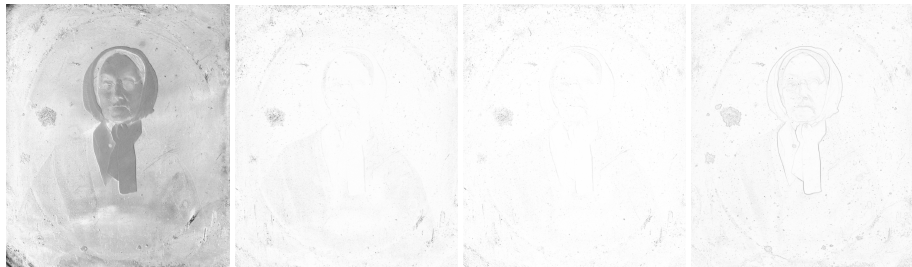
Figure 15. Difference images of daguerreotype between LLa mode and LRFB reference mode. Left to right: difference image, SSIM map, ESSIM map, filtered edges of the image scanned in LLa mode.